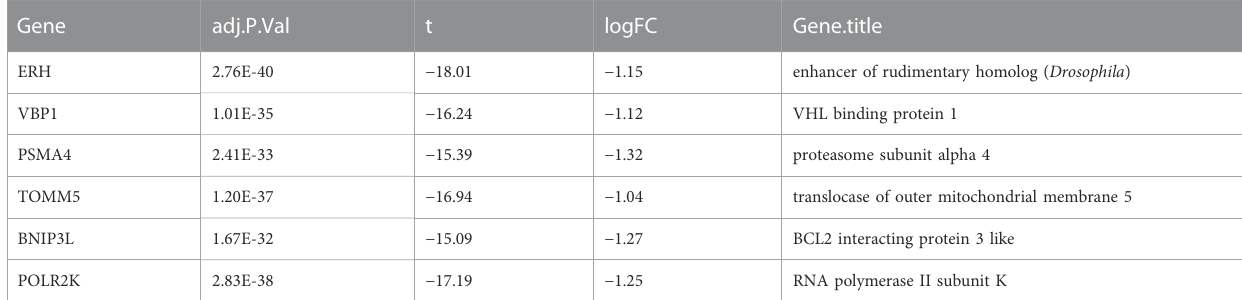
TABLE 2 Validation of the six differentially expressed genes in GSE46480.